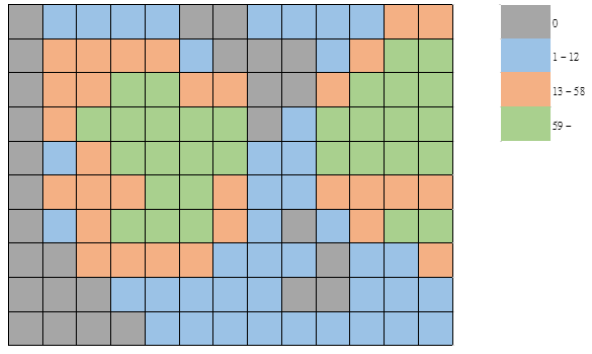
Figure 12. The distribution of tie points in image frame Gray means no tie point in sub-region. Blue means number of points in sub-region is between 1 and 12. Orange means number of tie points in sub-region is between 13 and 58. Green means that number of tie points in sub-region is more than 59.